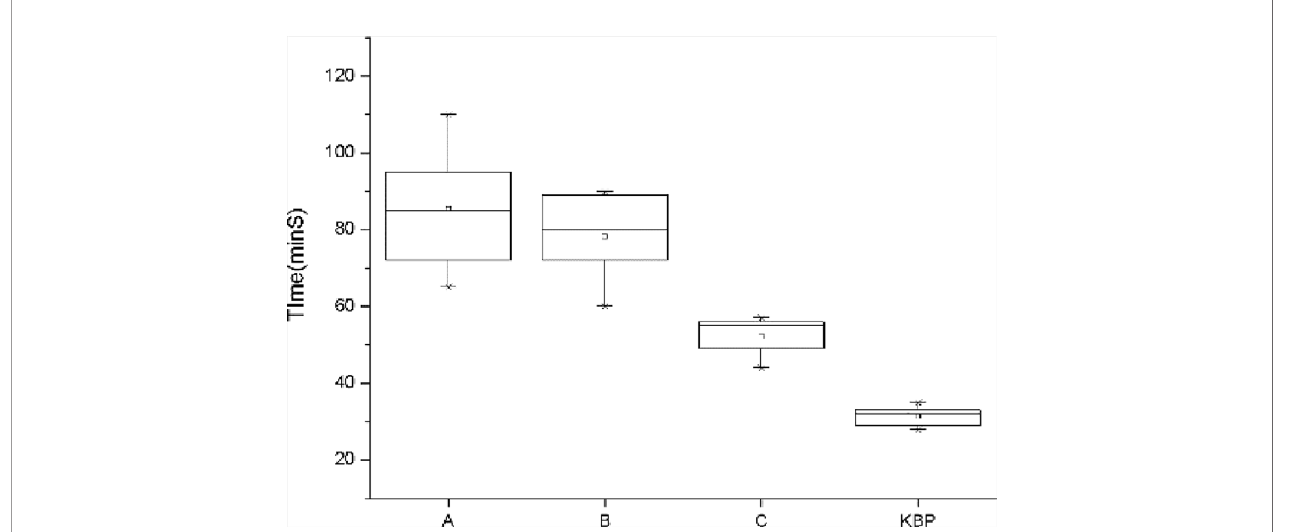
FIGURE 1 | Comparison of the planning time for dosimetrist A, B, C, and auto-planning. The error bar represents 1 standard